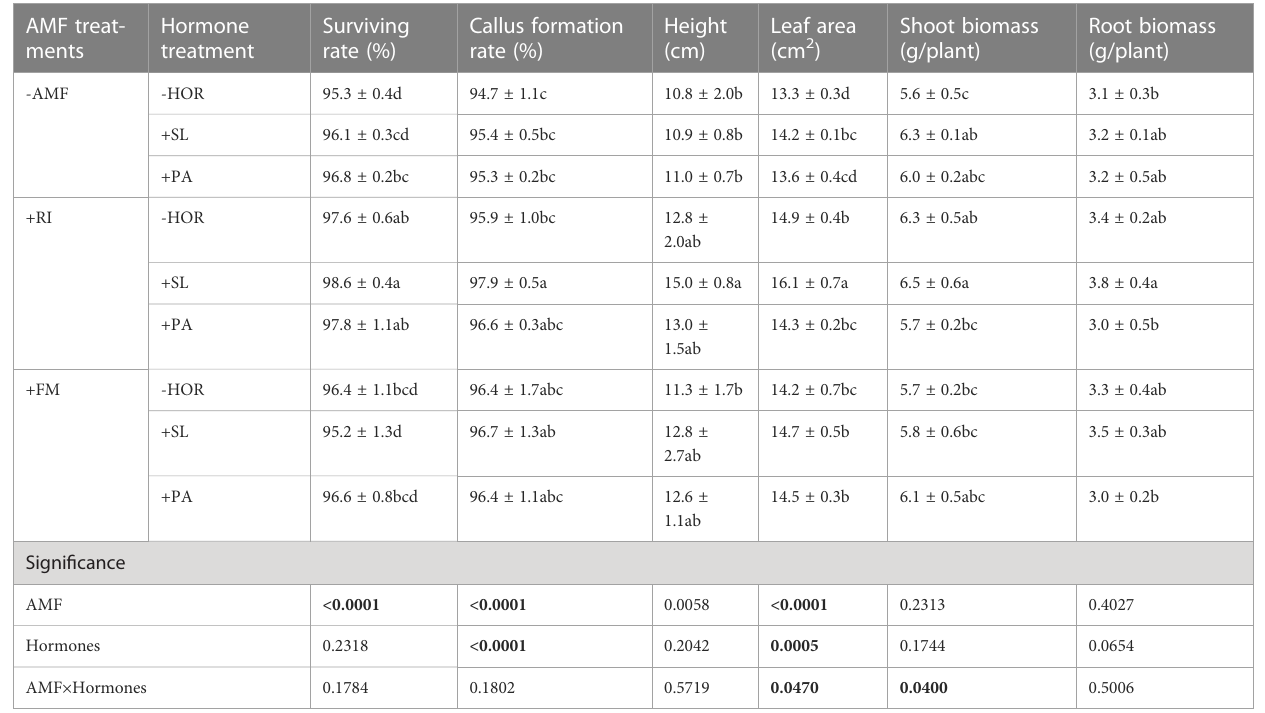
(Table 3), but had no signi fi cant impact on the total length and root surface area. Without the AMF inoculation, SL only signi fi cantly increased the average root diameter by 27.2%, while PA signi fi cantly increased the projected area and average root diameter by 17.2% and 18.2%, respectively. In combination with RI inoculation, SL signi fi cantly increased the total length, average root diameter, and root volume of tea cuttings by 61.9%, 39.3%, and 42.5%, respectively. However, the application of PA in combination with RI inoculation had no signi fi cant effect on root-system con fi guration. Following FM inoculation, SL signi fi cantly improved the average root diameter and root volume by 19.3% and 28.0%, respectively, while the application of PA only increased the average root diameter by 15.8%. Overall, the effect of the combination of AMF and hormones on the root system architecture was not always better than AMF inoculation or hormone treatment alone; only the speci fi ed combination of +RI + SL signi fi cantly improved root system architecture in this study ( P < 0.05). Two-way ANOVA showed that the AMF-hormone interaction had signi fi cant effects on the total length, average diameter, and volume of the root systems of tea cutting seedings ( P < 0.05 ).